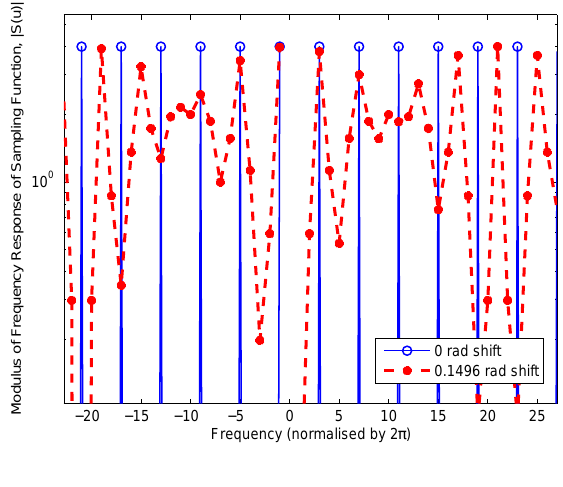
Figure 5. The phase and amplitude response of a Canesta XZ-422 system operating at 44 MHz with a 29% illumination modulation duty cycle as a function of relative phase of the illumination modulation. Only a portion of the remaining error is due to